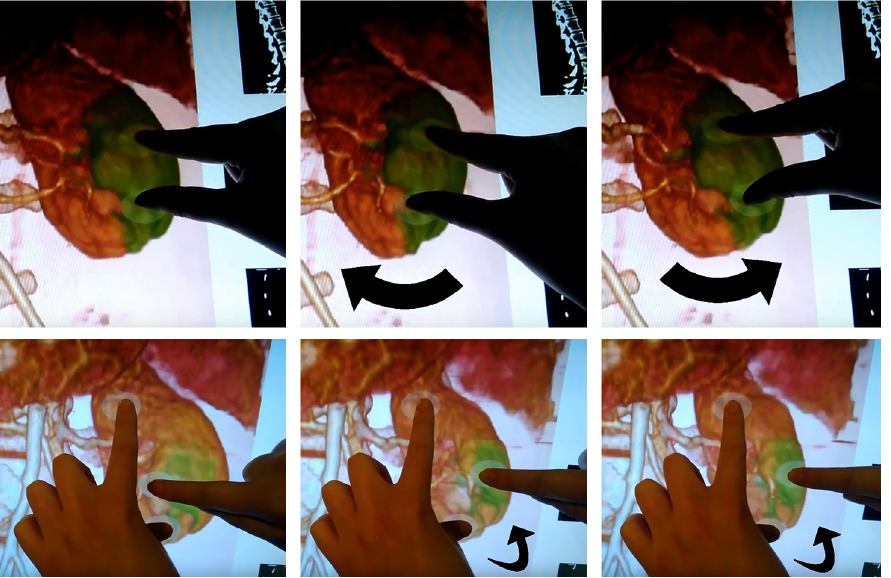
Figure 8. Video images of the user performing natural hands-on deformation of volumetric anatomy, interacting with the actual touchscreen. Top row : in-plane translation and rotation of the kidney using two fingers. Bottom row : out-of-plane rotation of the kidney using three fingers. The arrows show the direction of